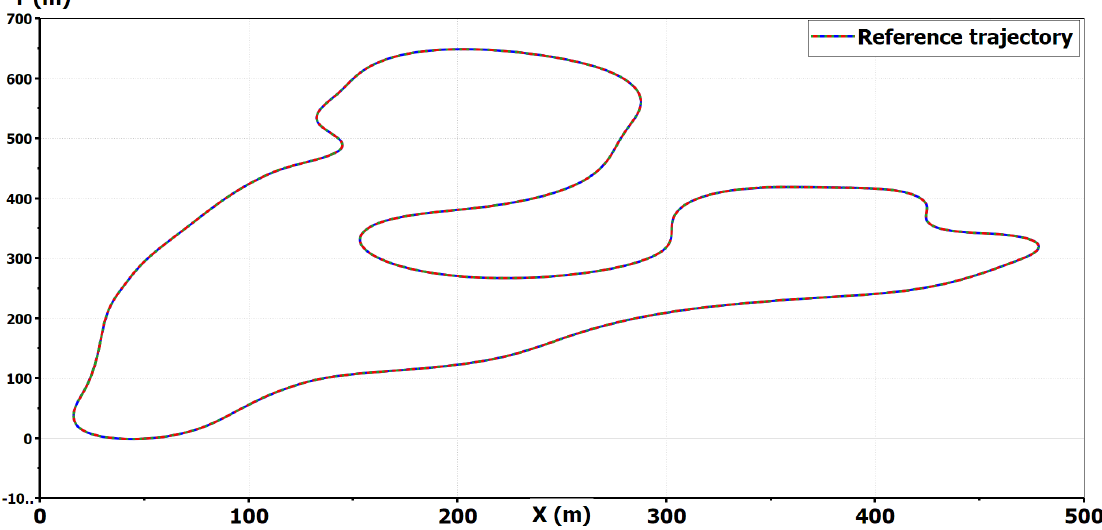
Figure 5. Magny–Cours